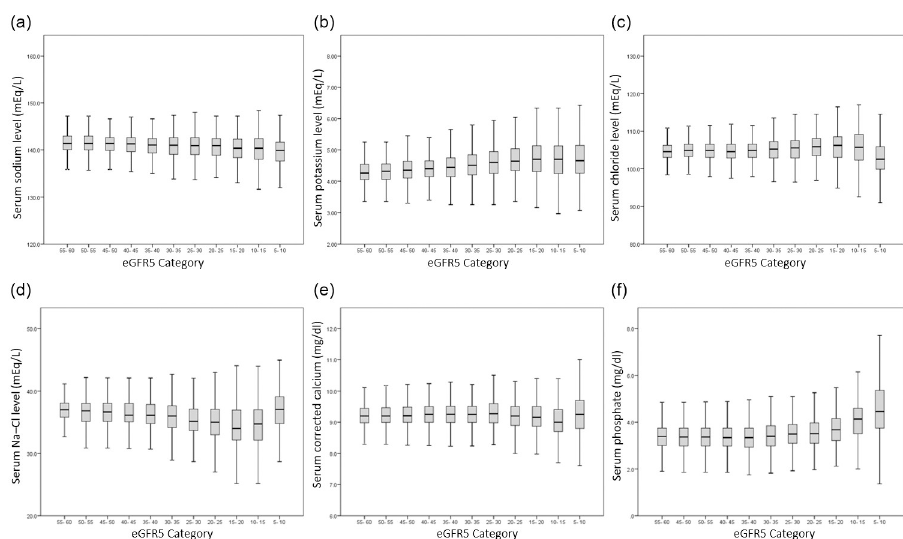
Fig 3. Mean serum electrolyte levels according to eGFR5 category. (a) Serum sodium level; (b) Serum potassium level; (c) Serum chloride level; (d) Serum Na–Cl level; (e) Serum corrected calcium level; and (f) Serum phosphate level. Abbreviations: Serum Na-Cl level, difference between serum sodium and chloride concentrations; eGFR, estimated glomerular filtration